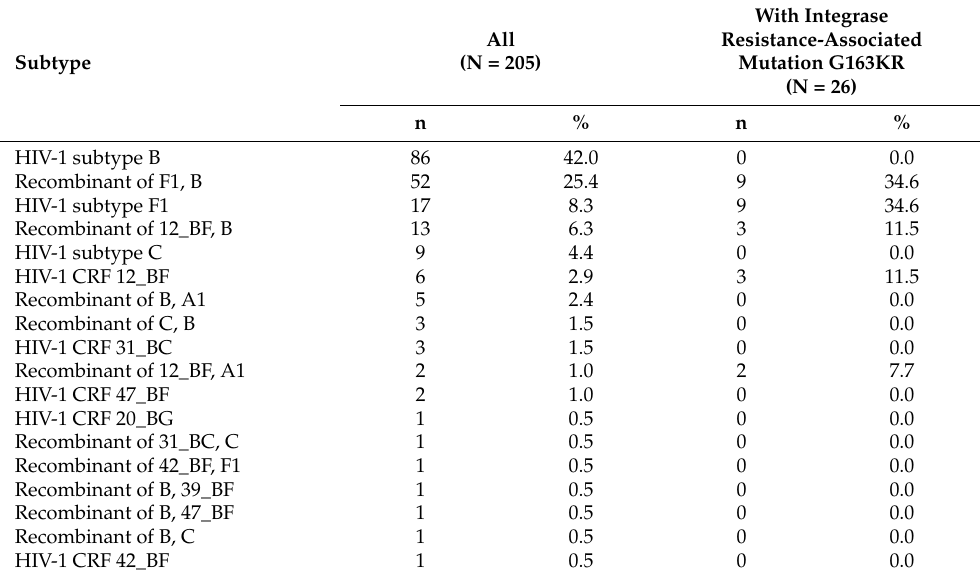
Table 2. Proportional distribution of HIV subtypes in adults initiating and reinitiating ART in Uruguay,